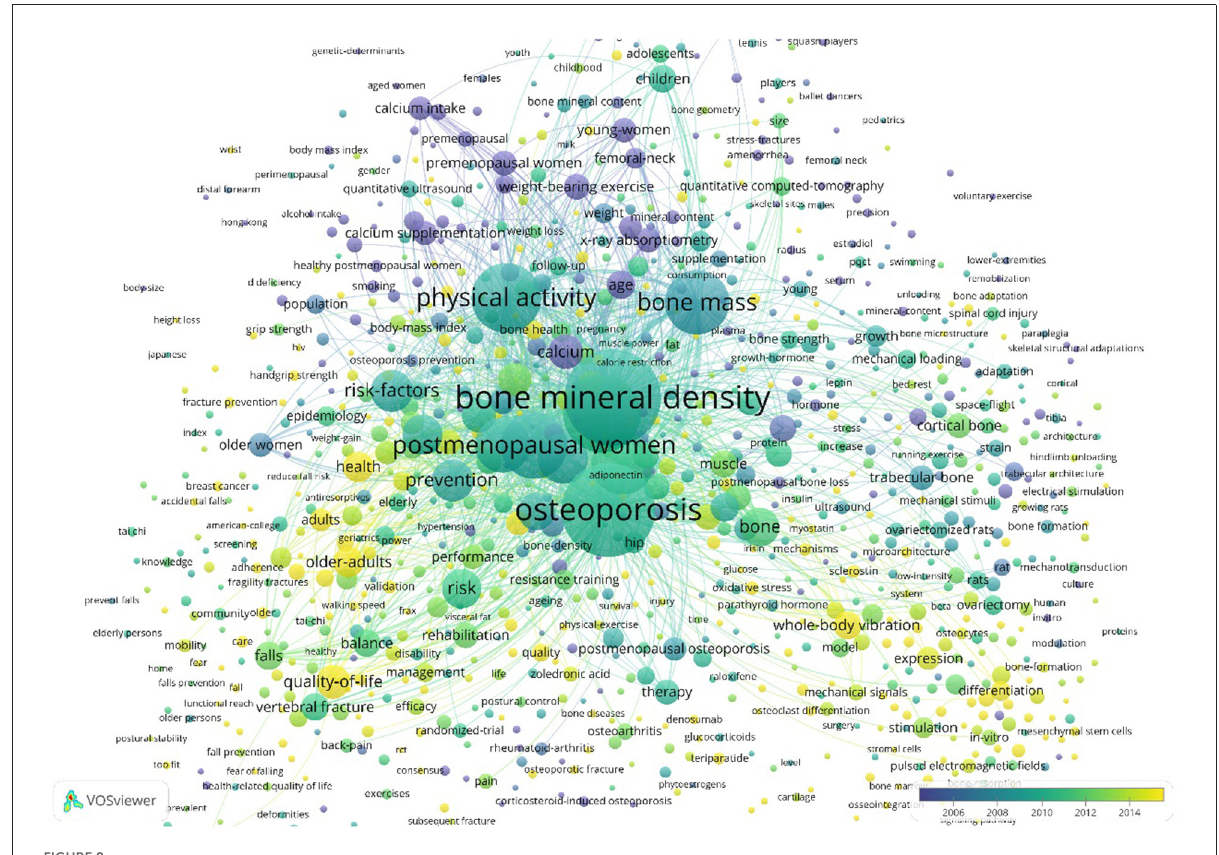
FIGURE8 Co-occurrence analysis of keywords by overlay